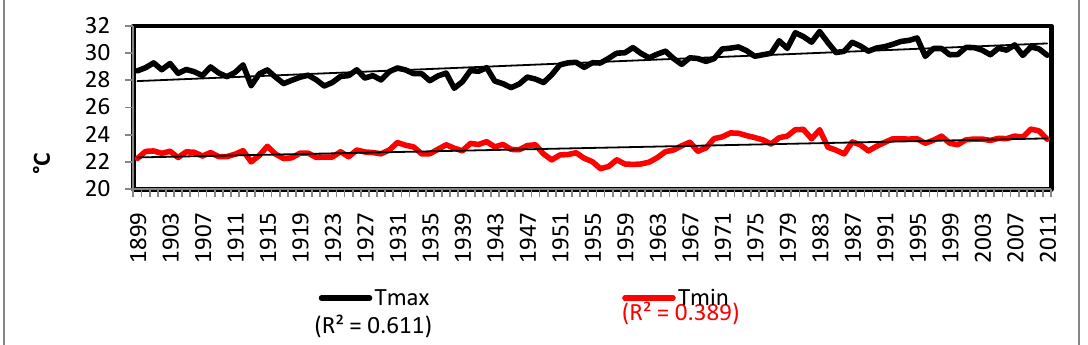
Figure 3. Upper Panel: Time series of annual average minimum and average maximum air surface temperature. Middle: Seasonal Trends in annual average minimum and maximum air temperature. DJF indicates December-January-February and JJA indicates June-July-August. Lower Left: Consecutive days > 90th percentile Tmin (25 °C). Lower Right: TN90p (San Juan